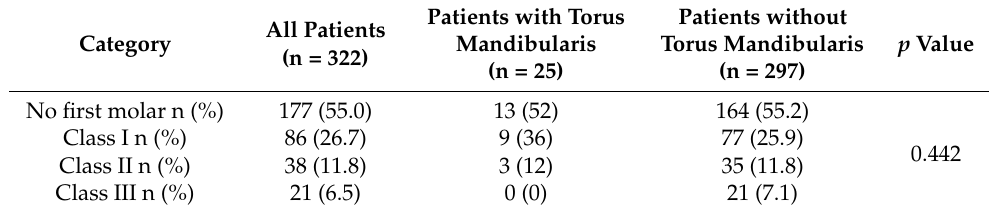
Table 5. Molar relationships of hemodialysis patients with and without torus mandibularis (n = 322).